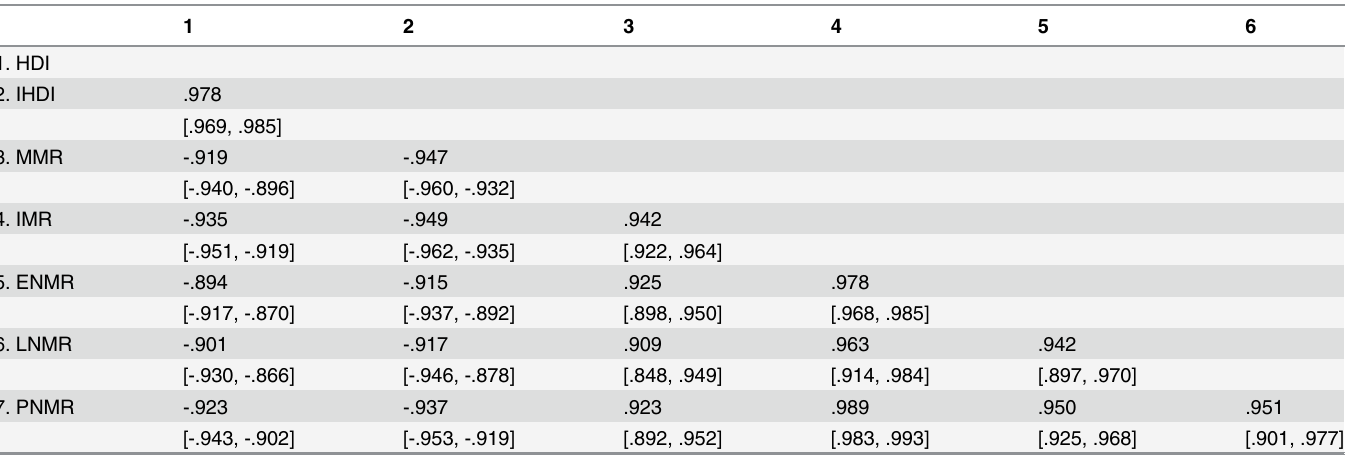
Table 1. Bivariate Pearson Correlation Coefficients (N =